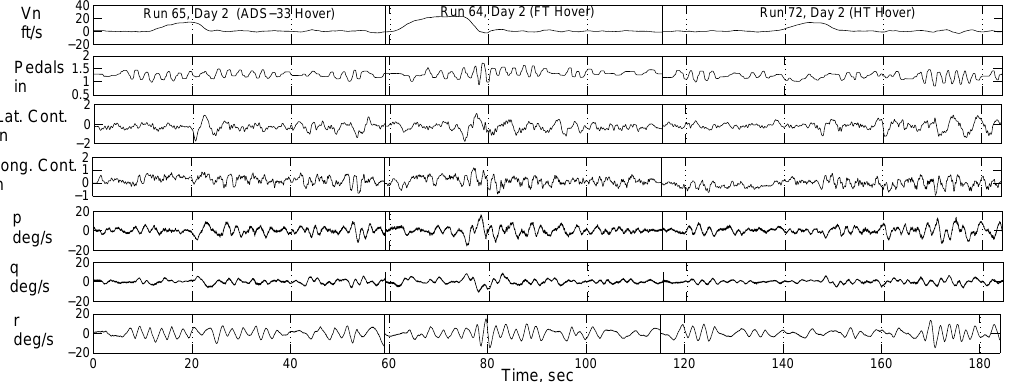
Figure 19. Comparison of results obtained from three hover